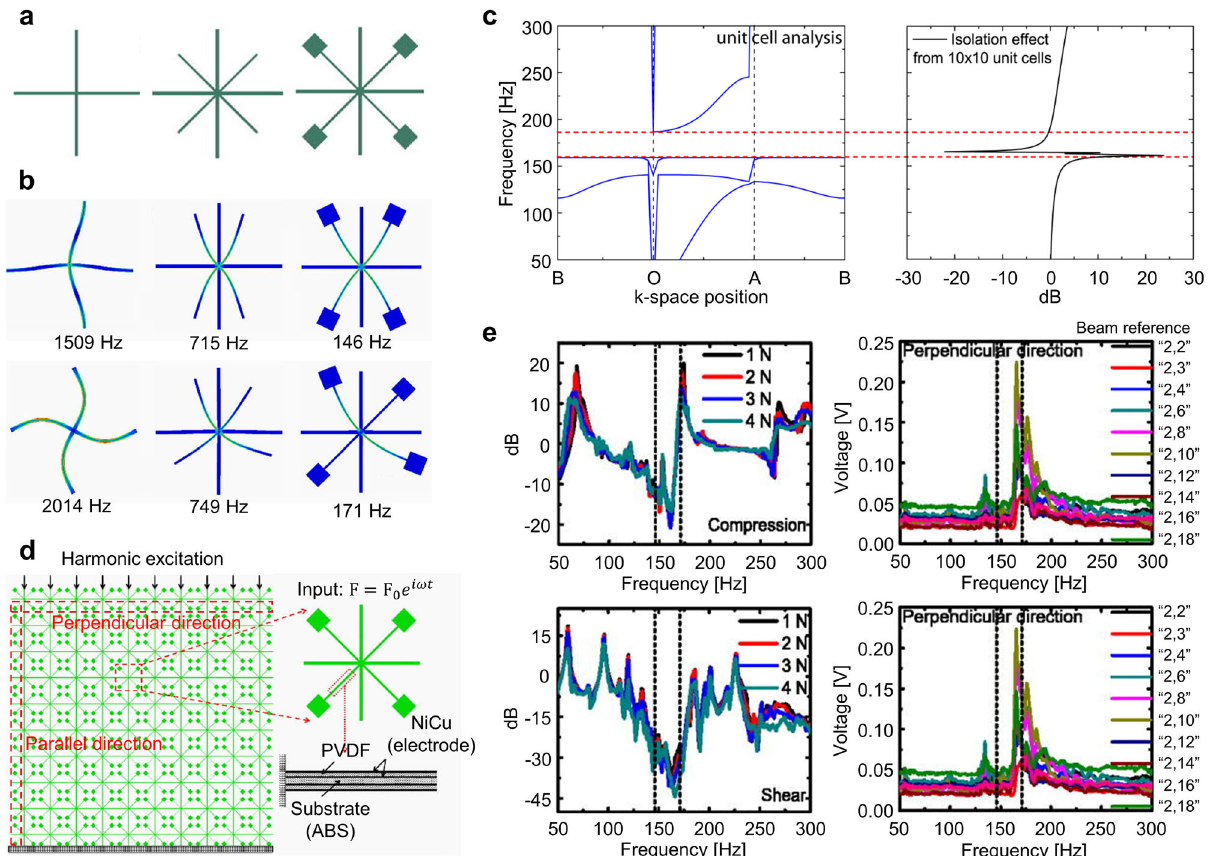
Fig. 1 Mechanical metamaterial (MM) consisting of locally resonant cantilevers for energy harvesting. a Topologies of the unit cell: Original square lattice, modi fi ed square lattice with cantilevers attached, and modi fi ed square lattice with cantilevers and masses attached. b Representative mode shapes of each unit cell. c Comparison of the force transmission spectrum to a band structure obtained from unit cell analysis by sweeping the wavevector along the contour of the irreducible Brillouin zone. d Array of mechanical MMs for energy harvesting. Piezoelectric material (polyvinylidene fl uoride fi lm (PVDF)) is attached at the substrate (acrylonitrile butadiene styrene (ABS) plastic) to convert localized kinetic energy to electrical energy. e Capability of designed MMs to fi lter mechanical waves: Compression longitudinal-wave test and shear transverse-wave test. “ X, Y ” : number of cantilevers in perpendicular and parallel directions to excitation, respectively. Within the bandgap range indicated by dashed lines, the waves do not propagate. The energy harvesting capability with longitudinal wave input force 5.34 N: Cantilevers in perpendicular and parallel directions to the excitations. Maximum output of voltage and power is found within the bandgap frequency measured across a 1-MW resistor 61 . Reprinted with permission from ref. 61